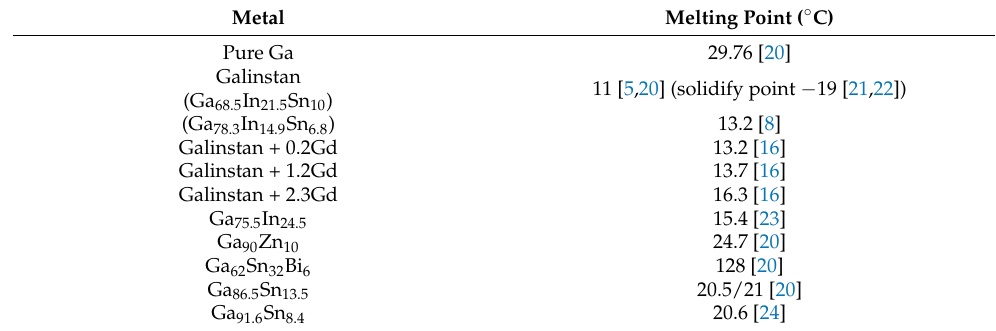
Table 1. Research status of the melting point of gallium-based liquid metal (each value in the metal column means the weight